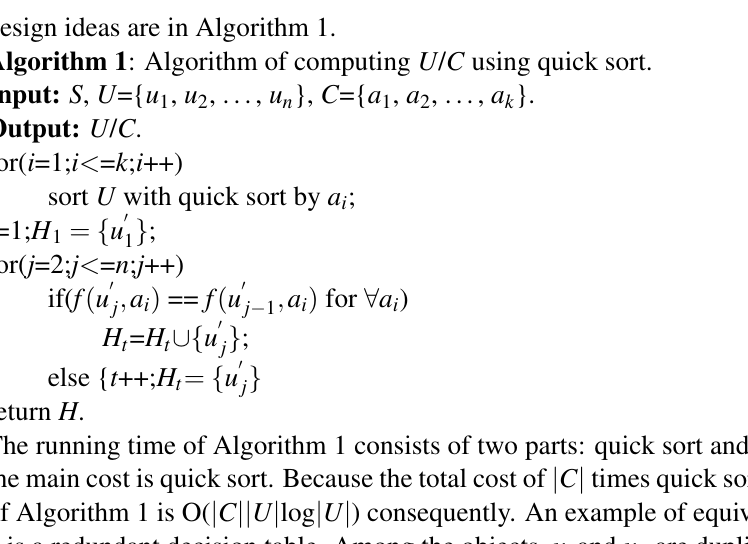
Algorithm 1 : Algorithm of computing U / C using quick sort.